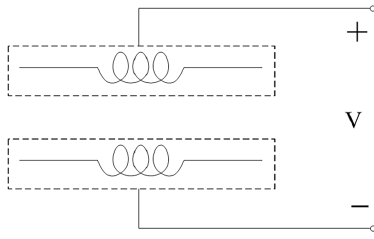
Figure 3. Schematic diagram of capacitance detection.